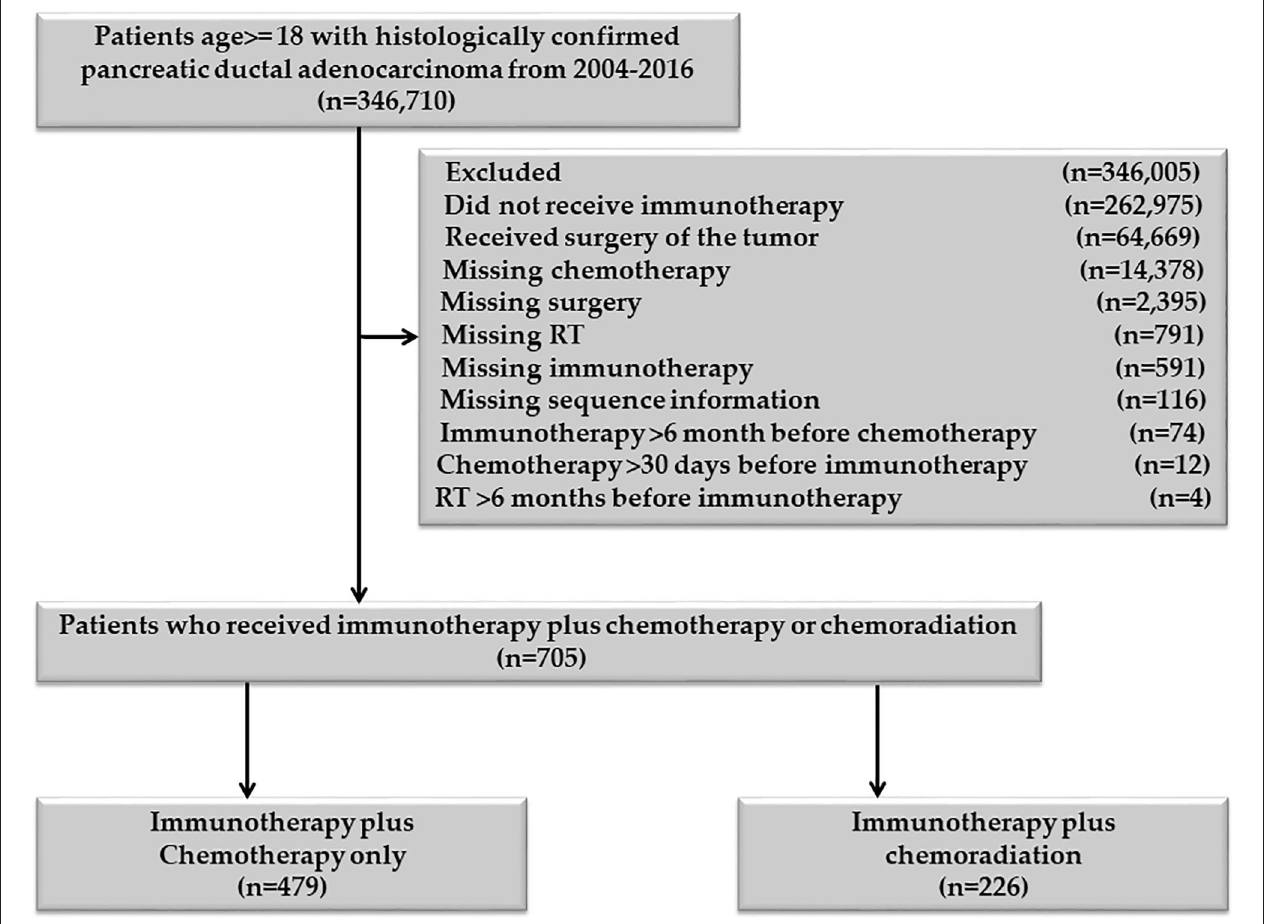
FIGURE 1 | Patient selection flowchart of the study